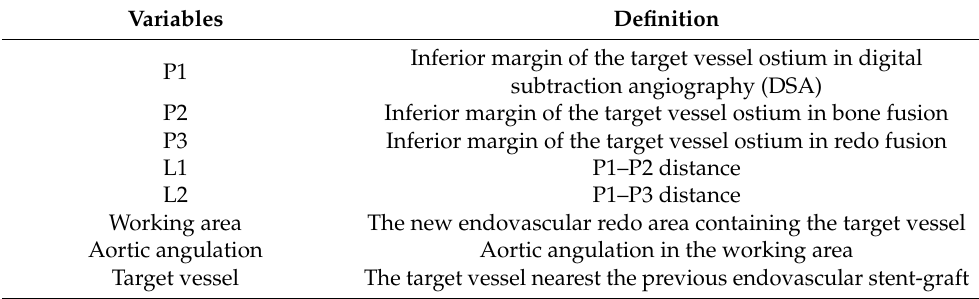
Table 1. List of the measurements obtained on the 3D workstation.